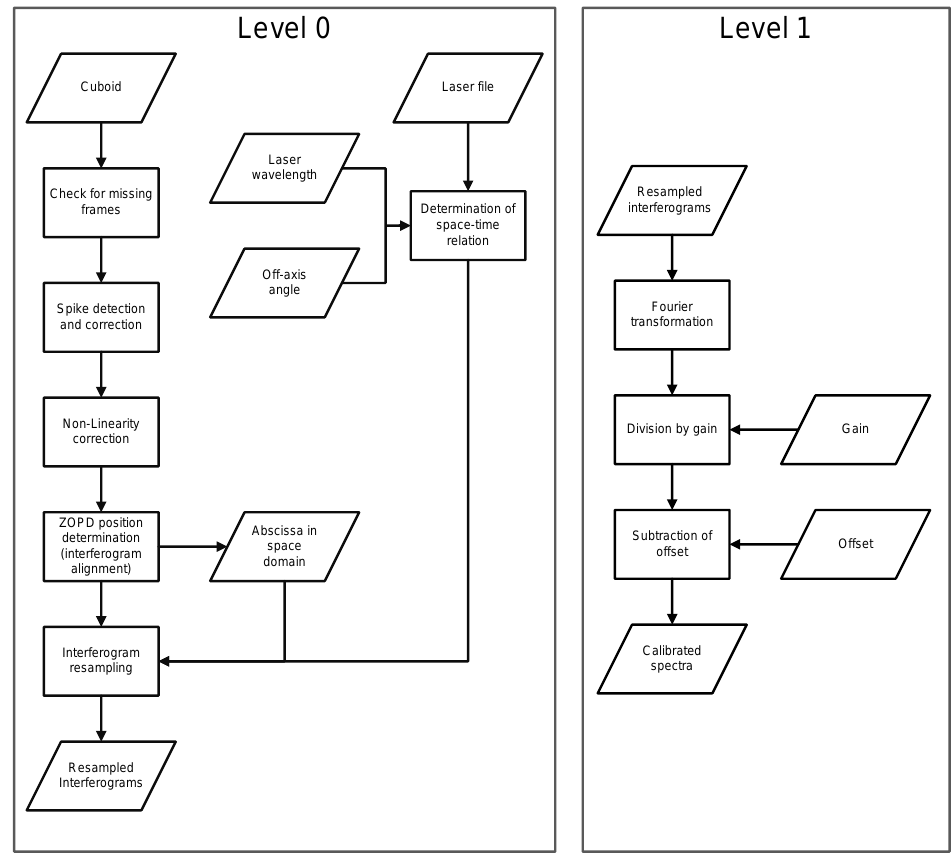
Figure 1. Simplified flowchart of the level 0 (left) and level 1 processing